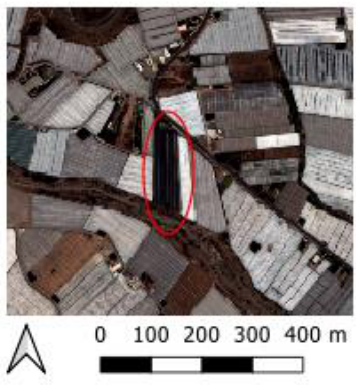
Figure 8 . Greenhouse with black shading net marked with a red ellipse over a WV3 image taken on July 11.